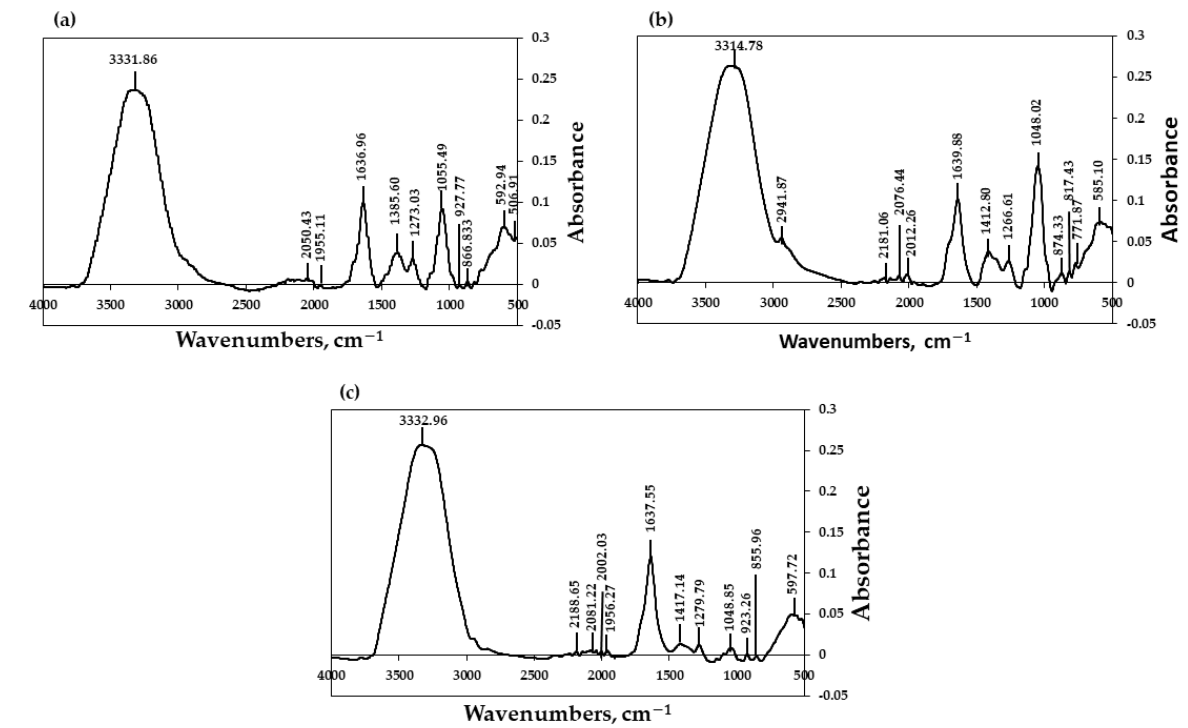
Figure 4. Fourier-transform infrared spectroscopy (FTIR) spectra of pineapple vinegar ( a ), pineapple vinegar mixed with red dragon fruit without peel ( b ), and pineapple vinegar mixed with red dragon fruit with peel ( c ).